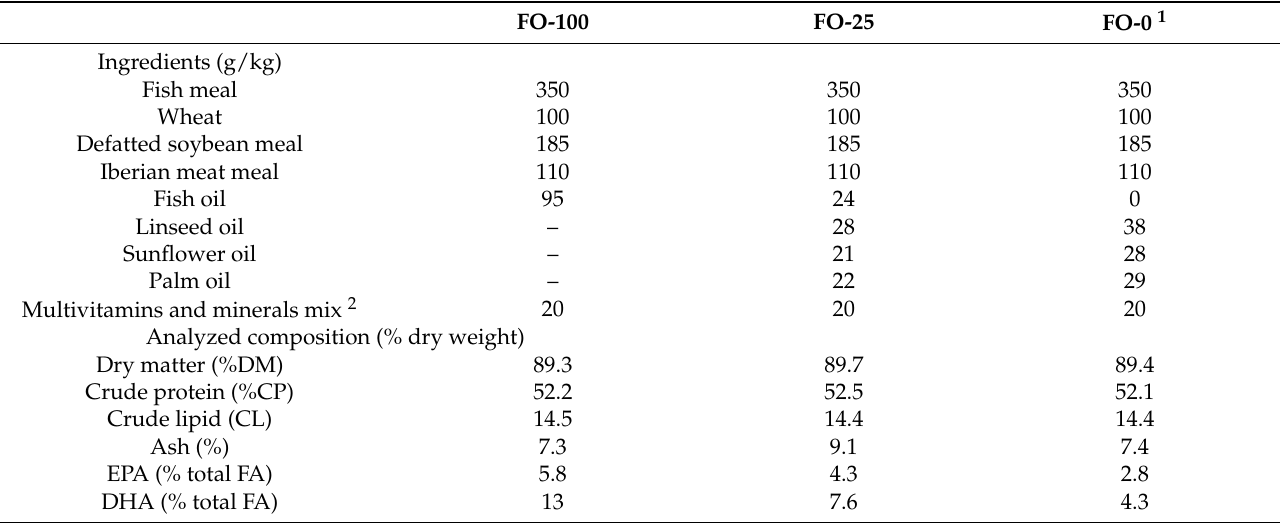
Table 5. Formulation (g/kg − 1 ) of the experimental diets. Feed ingredients and proximate composition. FO-100 FO-25 FO-0